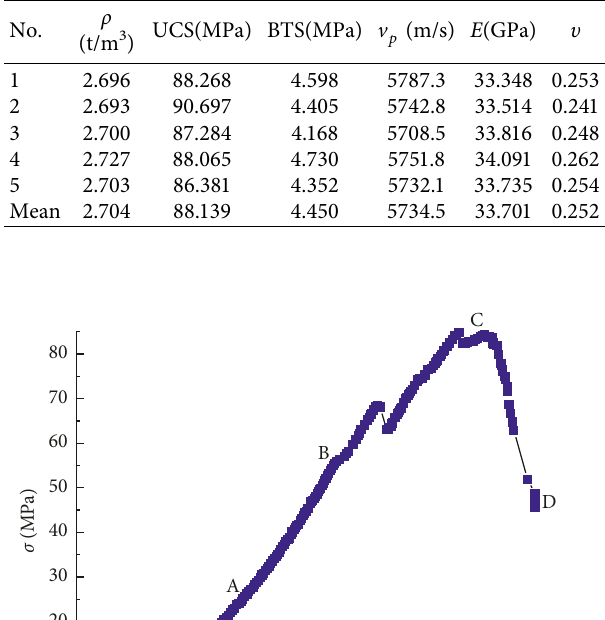
Table 1: Physical and mechanical parameters of intact rock.